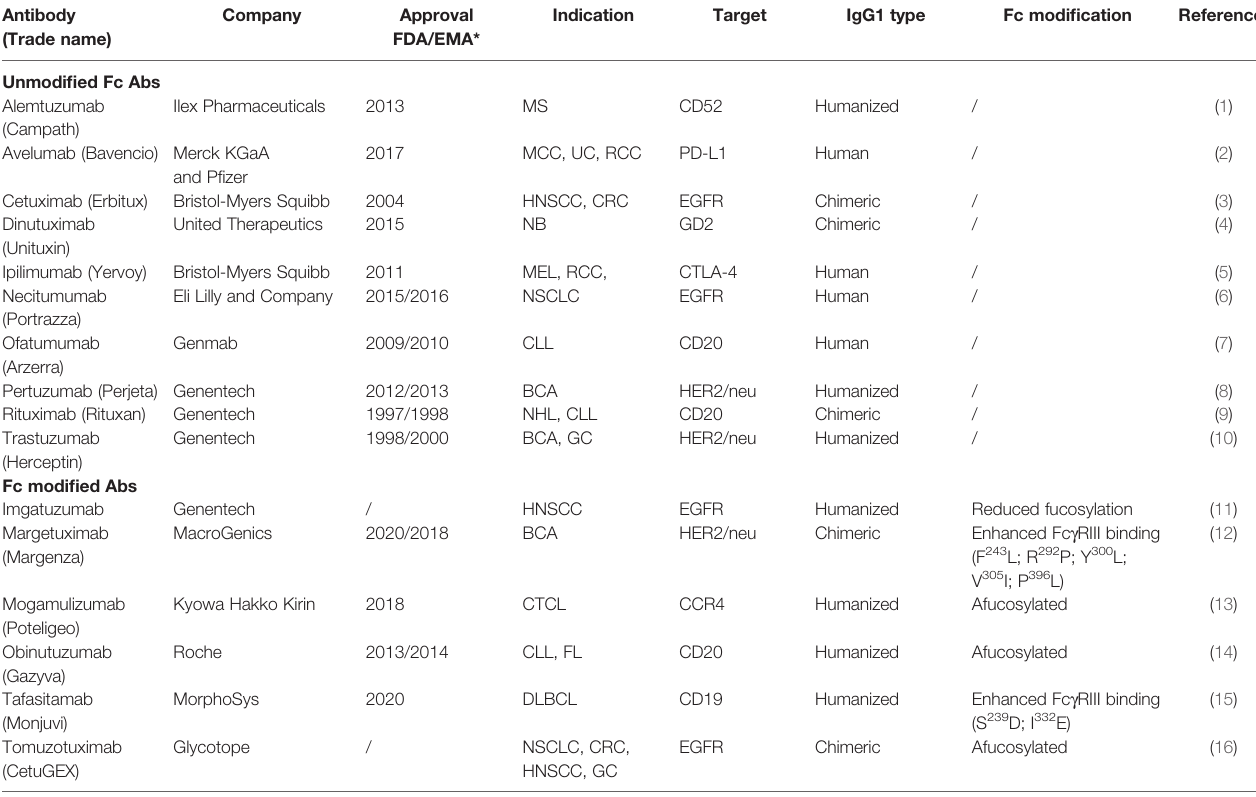
TABLE 2 | ADCC-mediating IgG1 therapeutic